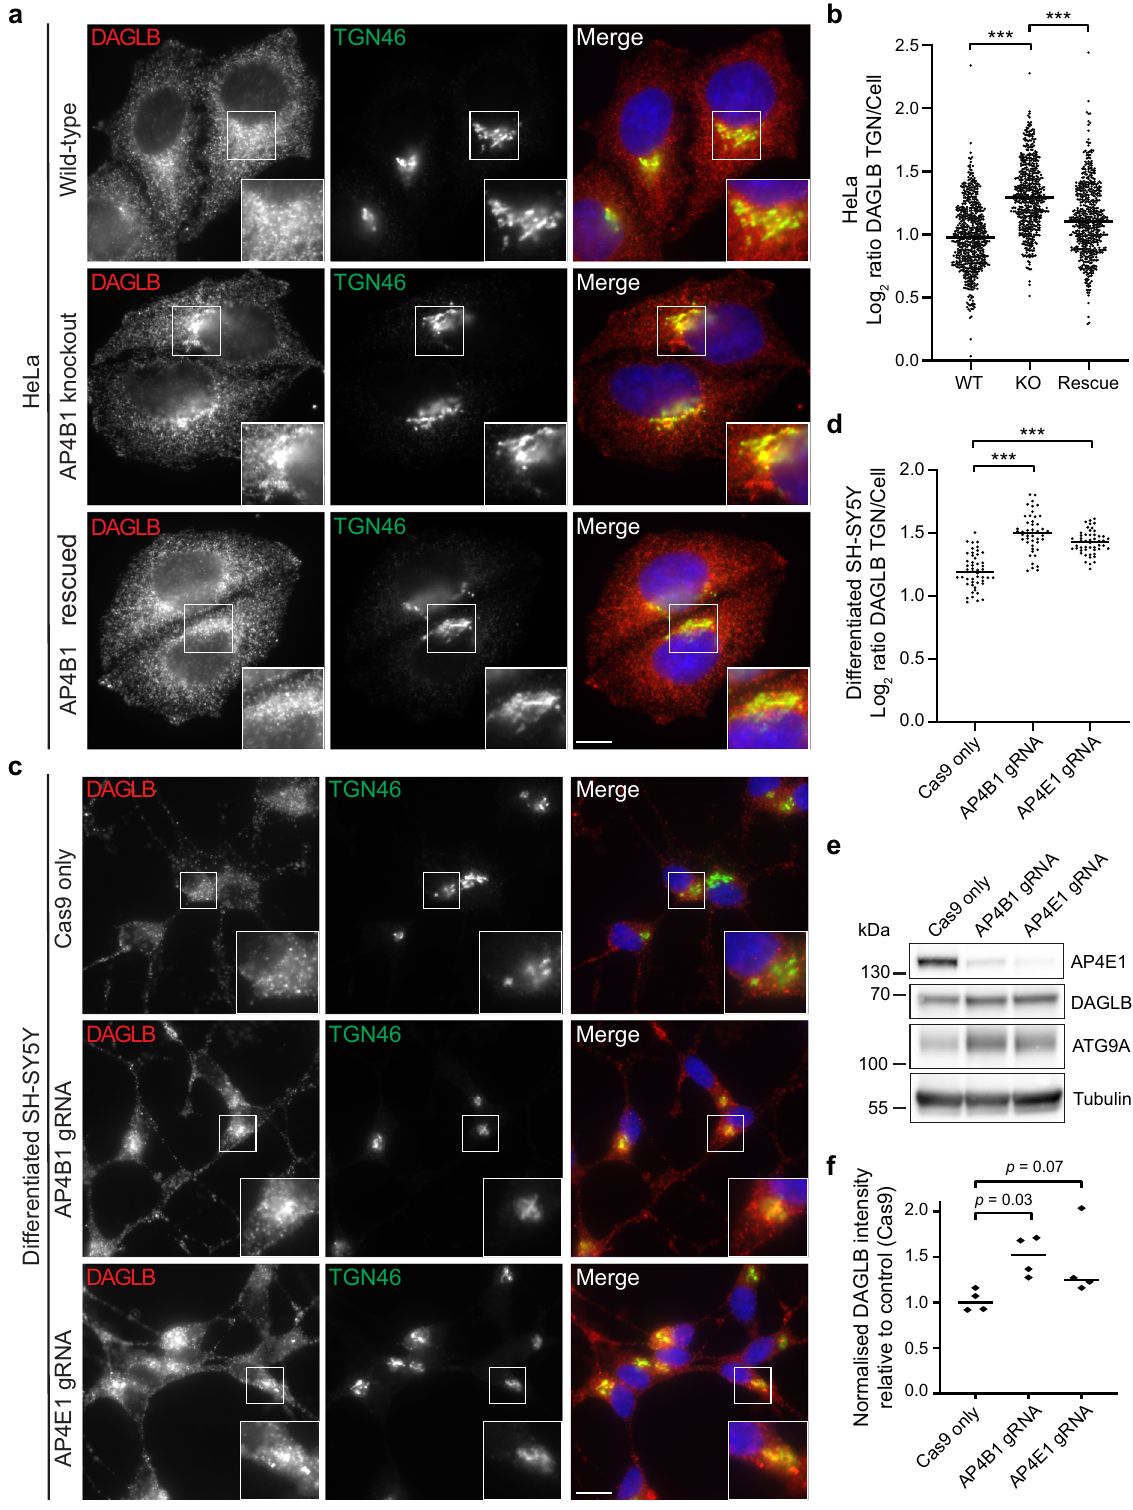
increased in AP-4-depleted SH-SY5Y cells in their undiffer- entiated state (Supplementary Fig. 2c, d). Collectively, these observations con fi rm DAGLB as an AP-4 cargo in HeLa and SH- SY5Y cells, and suggest that TGN export of DAGLB is a ubi- quitous function of the AP-4 pathway. Further supporting this notion, RNA-based expression analysis suggests that DAGLB and AP-4 are both ubiquitously expressed in human